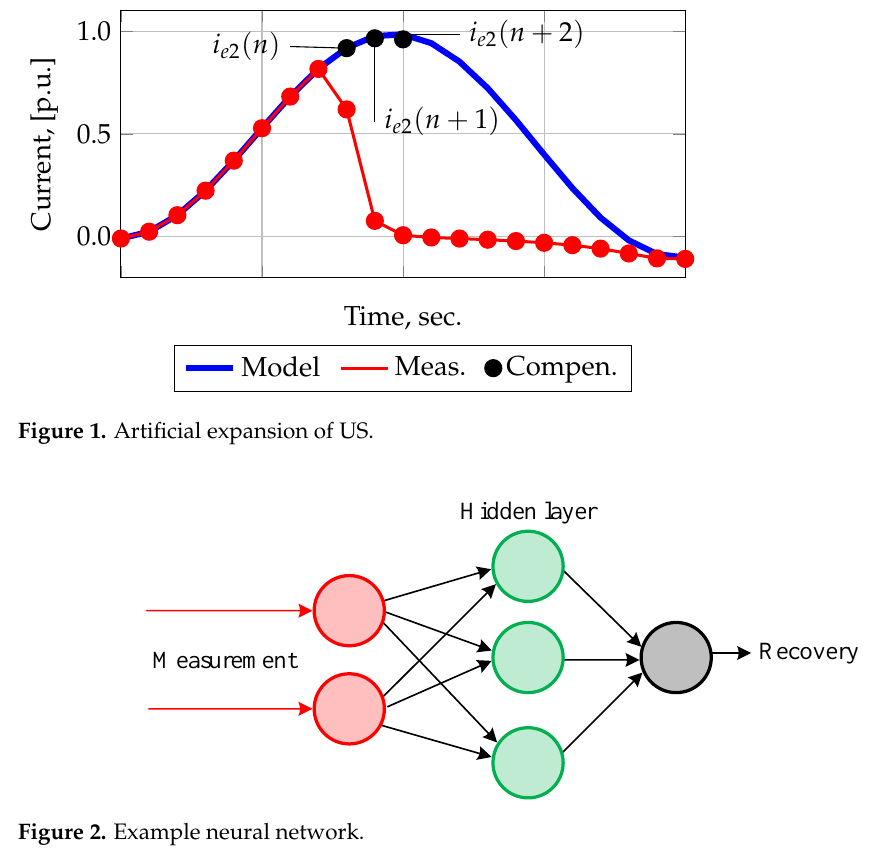
Figure 2. Example neural